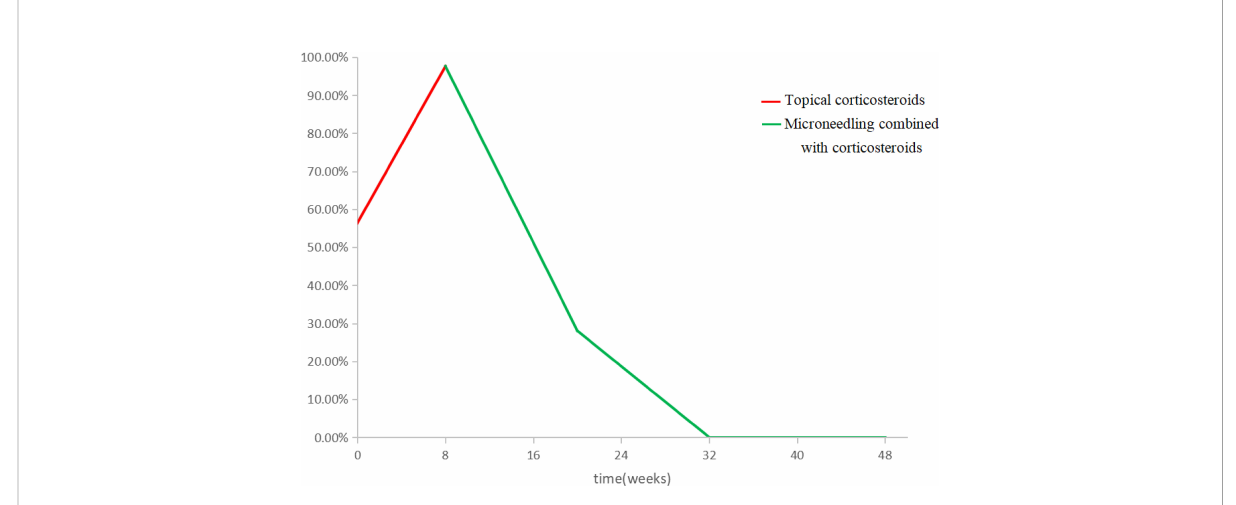
FIGURE 3 SALT changes before and after microneedle